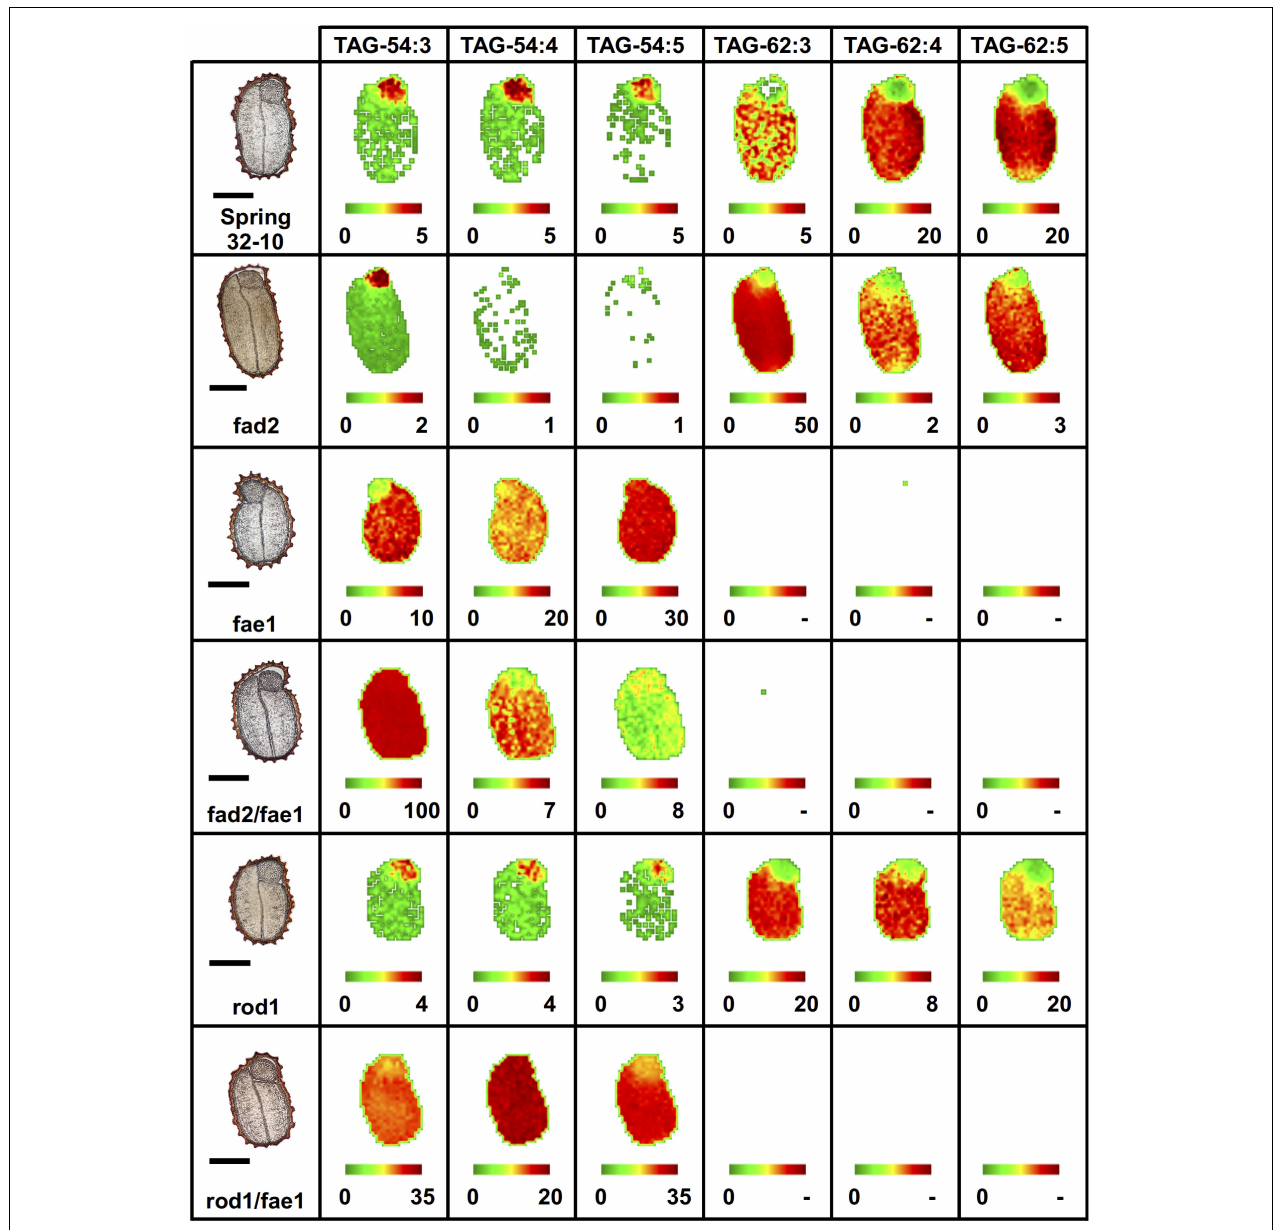
FIGURE 6 | Imaging of selected triacylglycerol (TAG) molecular species (54 vs. 62 carbon TAG) in wild-type and mutant fad2 , fae1 , fad2 fae1 , rod1 , and rod1 fae1 T. arvense mature seed sections. MS images are presented as false colored images with each pixel representing an individual scan rastered over the imaged seed section (microscopy image left, scale bar = 500 µ m). The color intensity scale ranges from green (low) to red (high) as the mol% value of the metabolite class. Each image mol% value is set individually (color scale below image) to show relative differences in abundance and localization between each seed type.